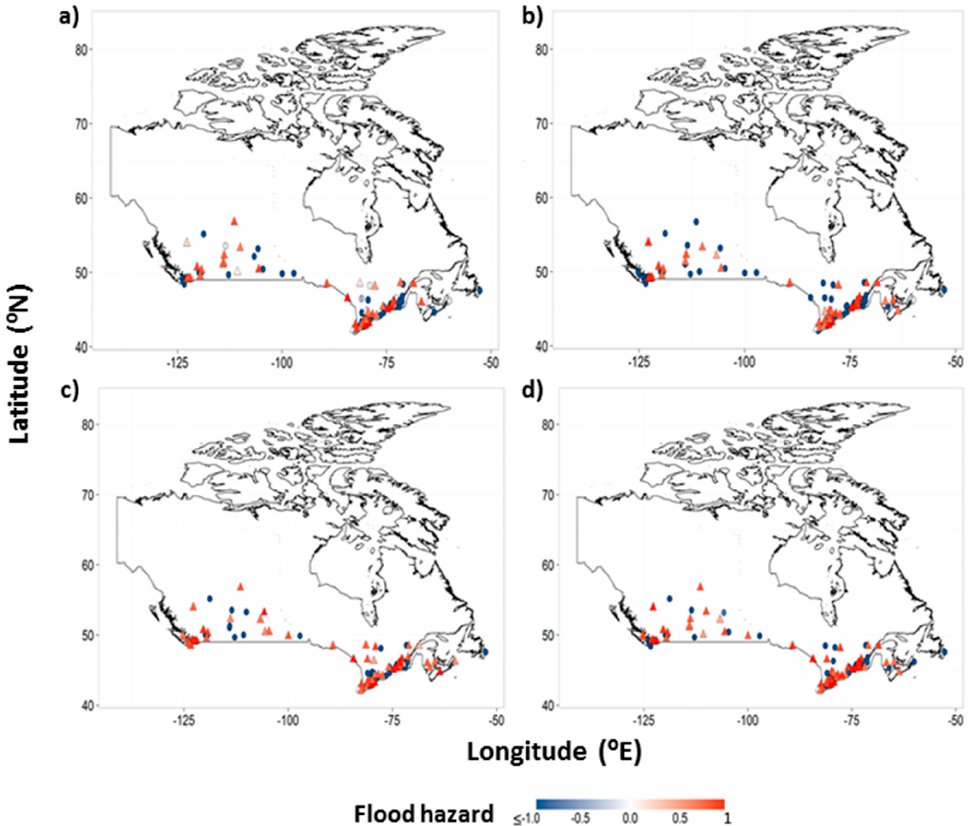
Figure 2. Flood hazard indices for 100 most populated cities in Canada under ( a ) RCP 2.6; ( b ) RCP 4.5; ( c ) RCP 6.0, and ( d ) RCP 8.5 obtained from robust GCM median approach. Positive values are presented as triangles whereas negative values are presented as dots. The index values below − 1 are only shown categorically to show the spatial heterogeneity of the